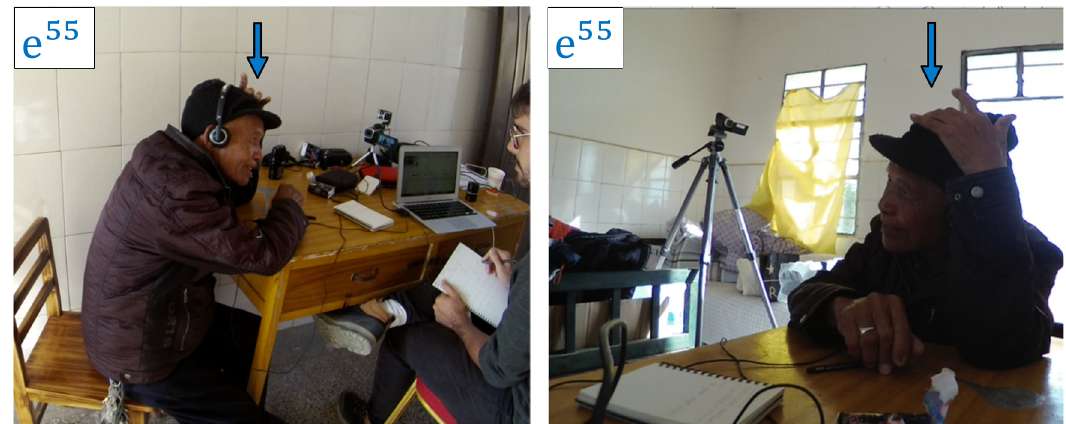
Figure 2: BLW points to his own hat. Co - timed with speaker deixis. Both photos/stills/frames correspond to the same frame as captured by a lateral and a frontal camera,